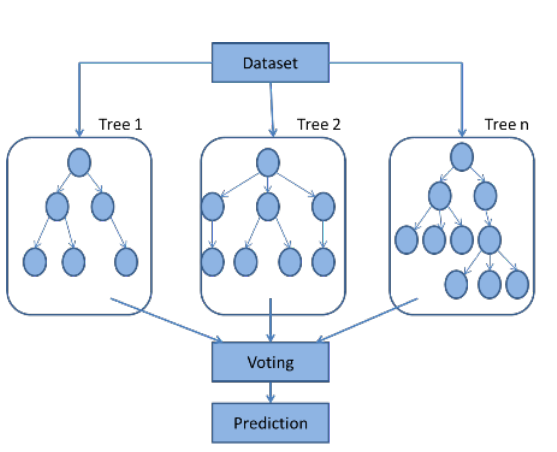
Figure 4 . Extreme Gradient